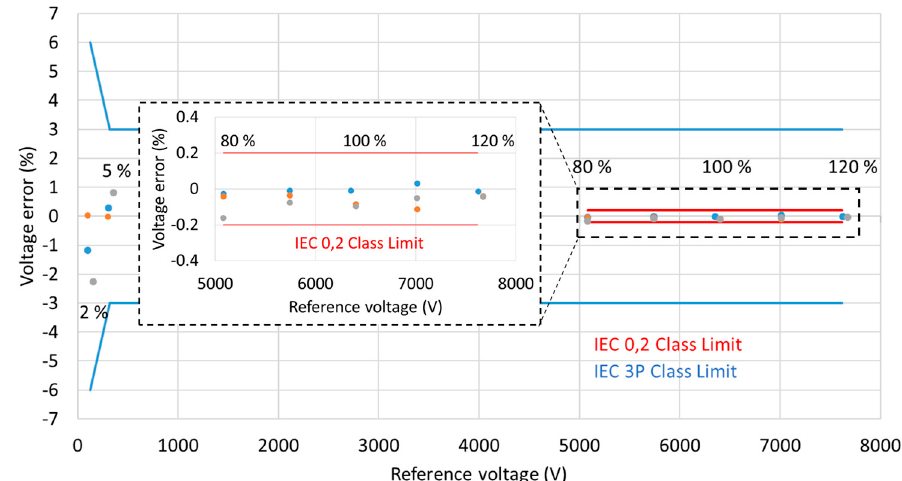
Figure 27. MV PVT voltage errors. The error limits for the 0.2 metering class are marked by the red lines for the range of 80–120% of the sensor rated voltage (6.35 kV). The 3P protection class limits are marked by the blue